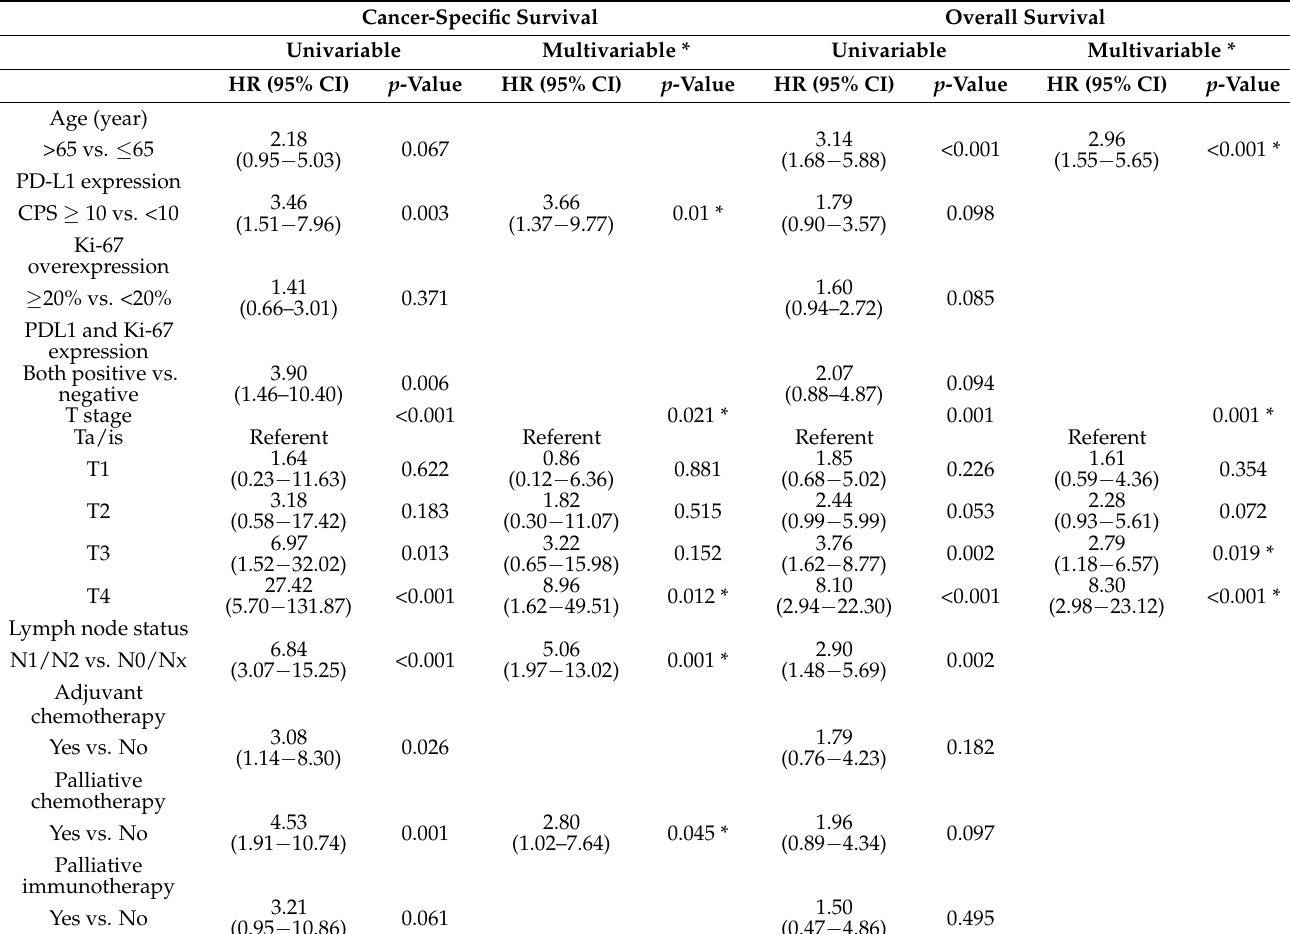
Table 3. Univariable and multivariable analyses by the forward stepwise selection of the clinicopathological features for the prediction of CSS and OS in patients with